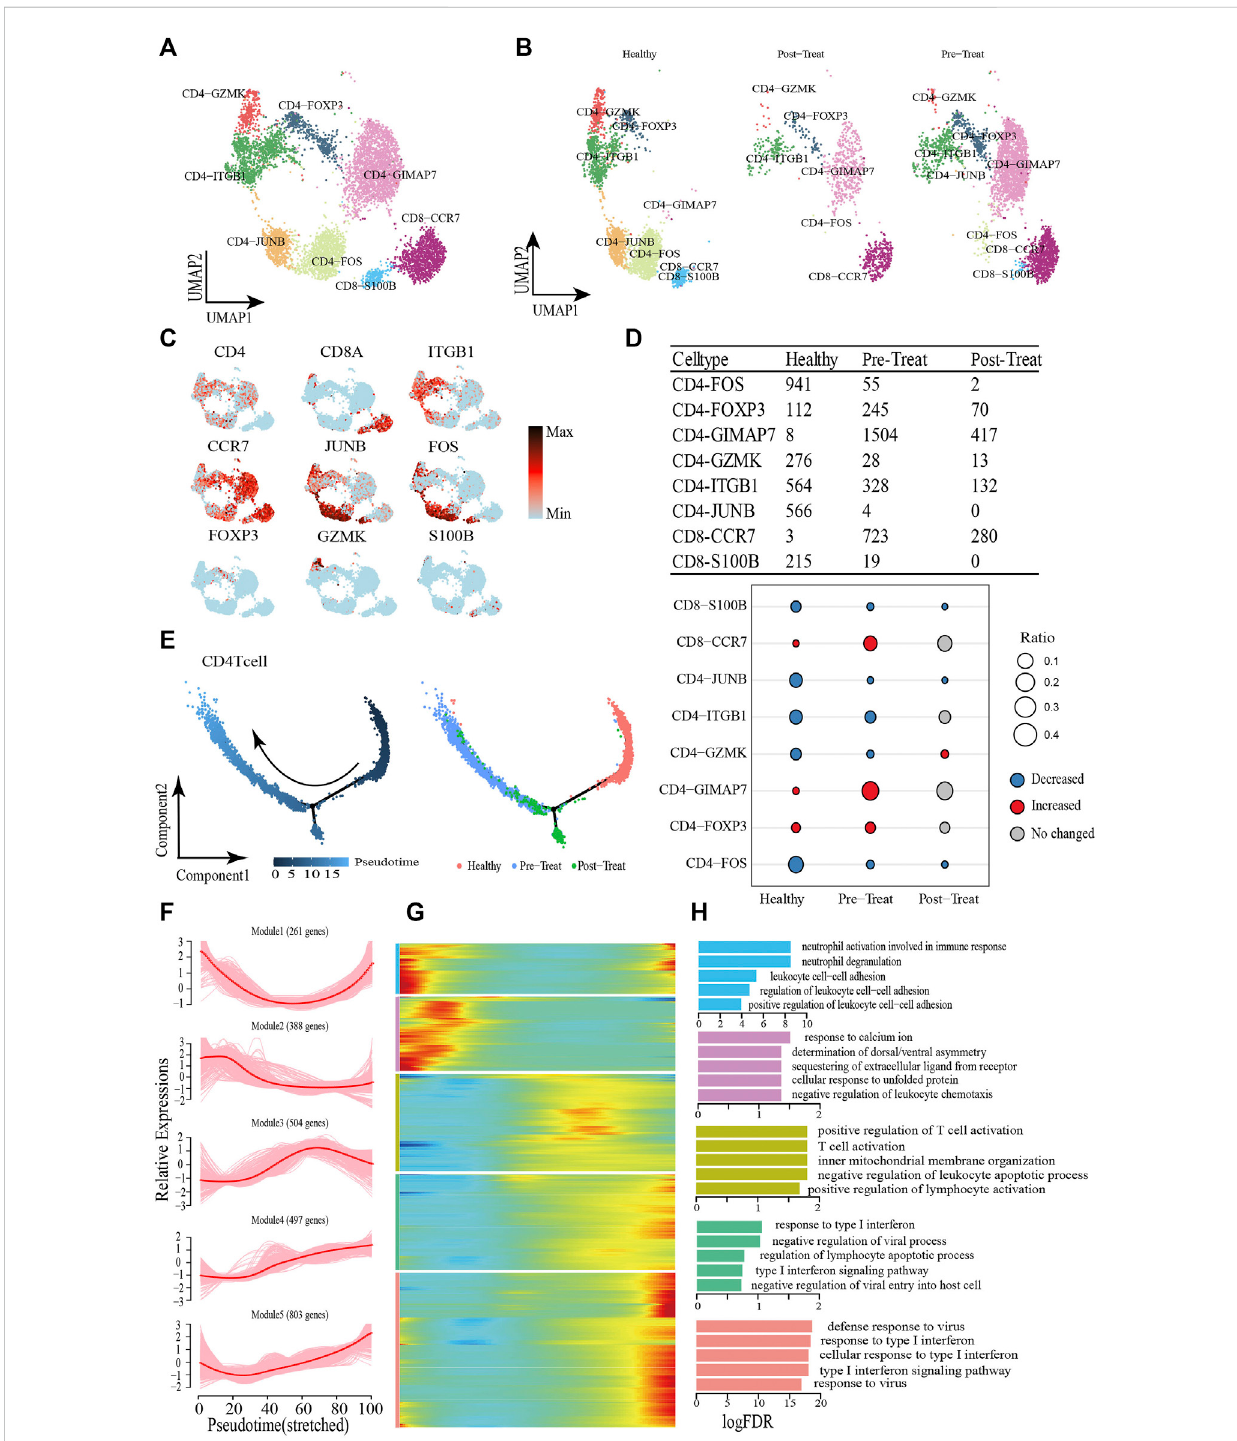
FIGURE 4 Dynamic change process of T cell in response to JDM disease occurrence and treatment. (A,B) Visualization of T cell sub-clusters in human peripheralbloodsample via UniformManifoldApproximationandProjection(UMAP)plotsbycellidentity (A) anddifferentstages (B) . (C) Thefeatureplots of marker genes of T cell sub-clusters. (D) Heterogeneity of cell type composition of T cell sub-clustersin healthy control, pre-treatment, and post- treatment groups. The table shows the number of each cell type in each group (up); and the bubble chart represents the changes in the cell ratio of cell types between the pre-treatment and healthy control groups, and between the post- and pre-treatment groups in peripheral blood (down). (E) Pseudotime trajectory (Monocle analysis) of the CD4 + T cell sub-clusters. Cells are colored based according to the predicted pseudotime (left) and groups (right). (F) The expression dynamics of top DEGs were cataloged into fi ve major clusters in a pseudotime manner. (G) A heatmap shows the differentexpression patternsofrepresentative DEGs (cataloged in fi veclusters)along thereprogramming trajectory. Color keyfrom blue to redindicates relative expression levels from low to high. (H) GO enrichment analyses of each gene